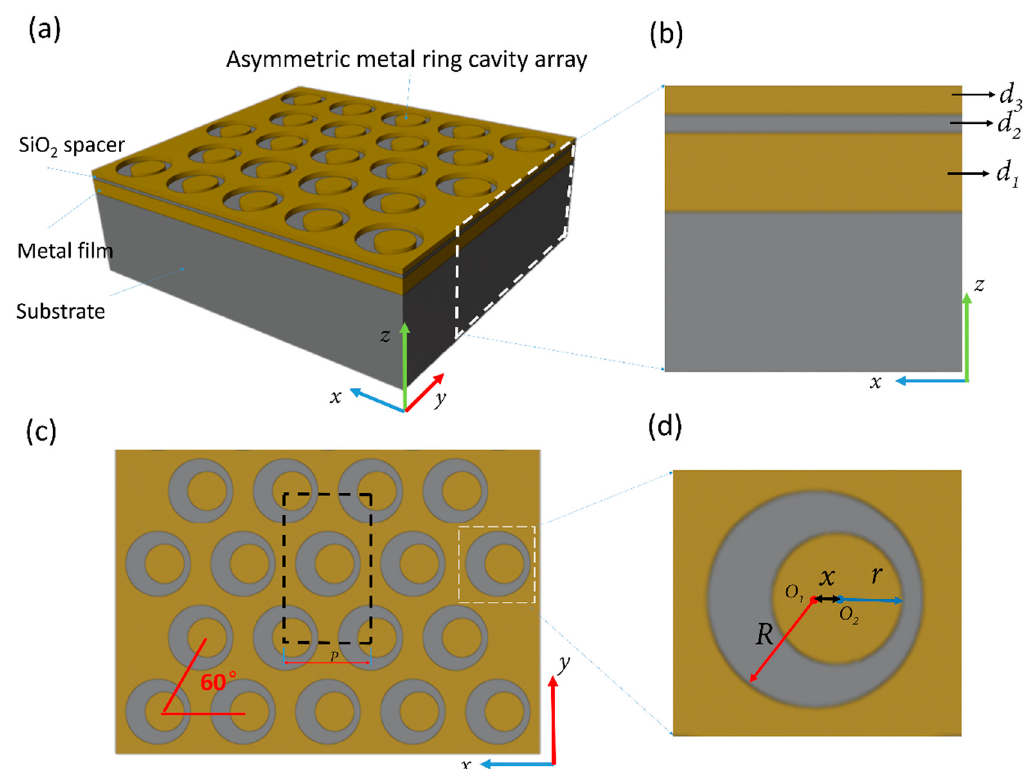
Figure 1. Schematic diagram of the structure we designed. ( a ) 3D view of the structure. The four layers from bottom to top are glass substrate, metal film, SiO 2 spacer layer, and asymmetric metal ring cavity array. ( b ) Front view of the structure (as shown in the white dotted box in (a)). d 1 and d 2 are the thickness of the metal film and SiO 2 spacer. ( c ) Top view of the structure. The black dotted rectangle is the simulation area, and the red line is the period and the angle of period change. ( d ) Some parameters of the structure. r is the radius of the disk, R is the radius of the hole, and x is the center distance between the hole and the disk.